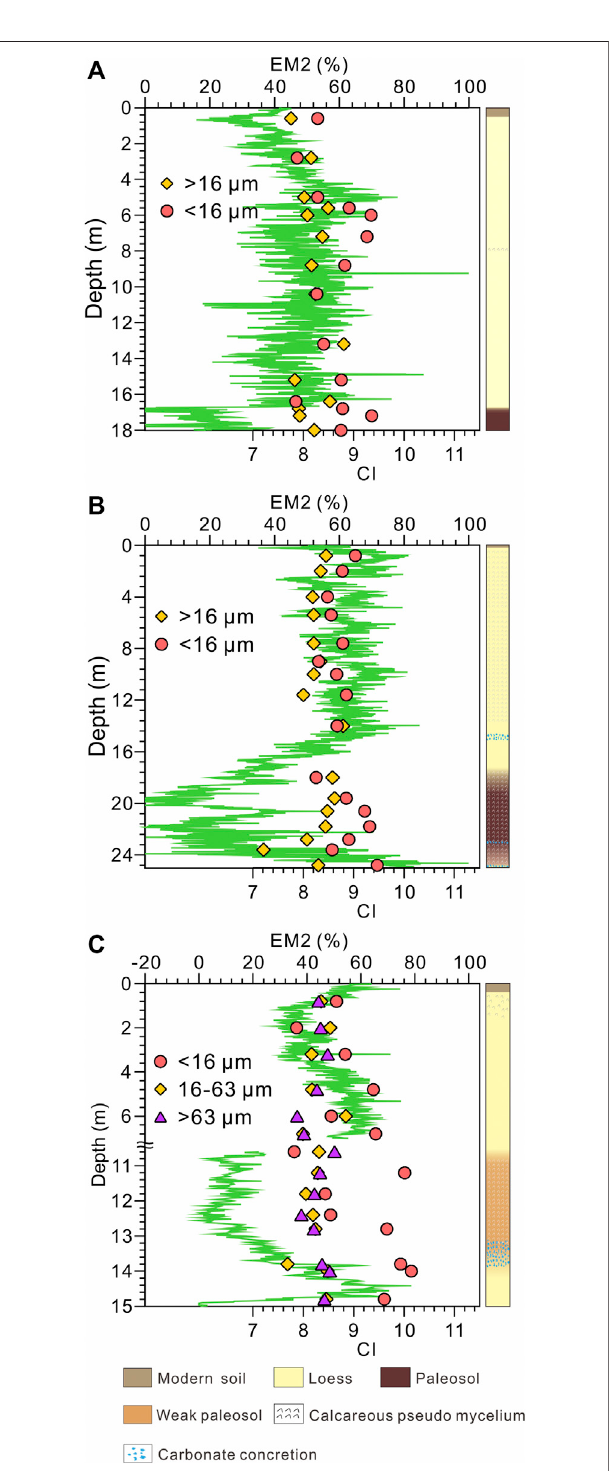
FIGURE 5 | Variations in CI and mean grain size of the BSK (A) , CMG (B) , and FS18 (C) sections.